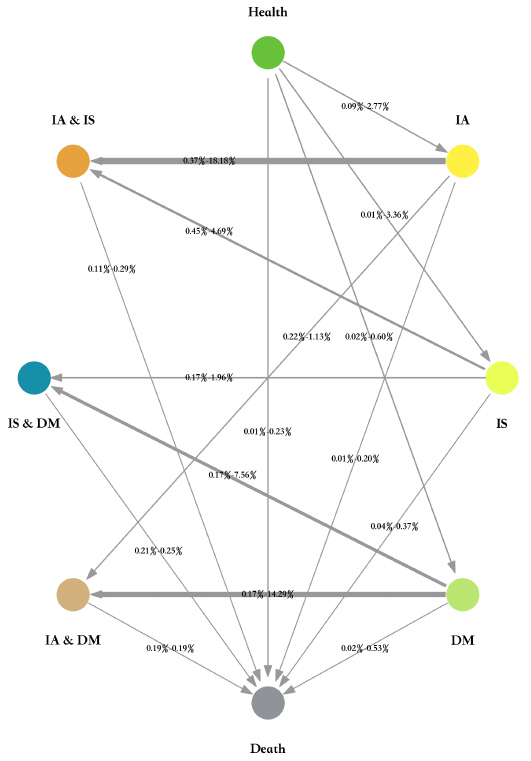
Figure 1. Transition probability graph of 1-year interval group.